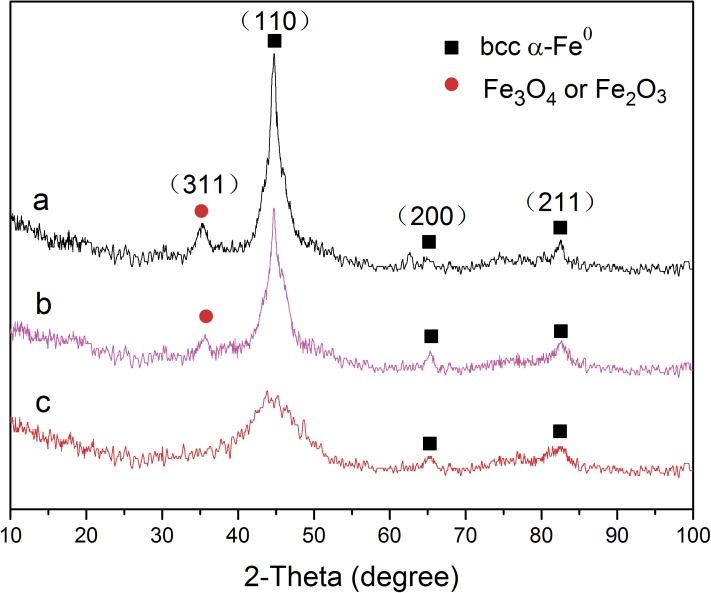
XRD images of (a) bare-Pd/Fe, (b) HPMC-Pd/Fe, and (c) PAC- Pd/Fe NPs. Fe loading is 0.4 g L-1 with Pd 0.3 wt% of Fe, cellulose is 1 g L-1.